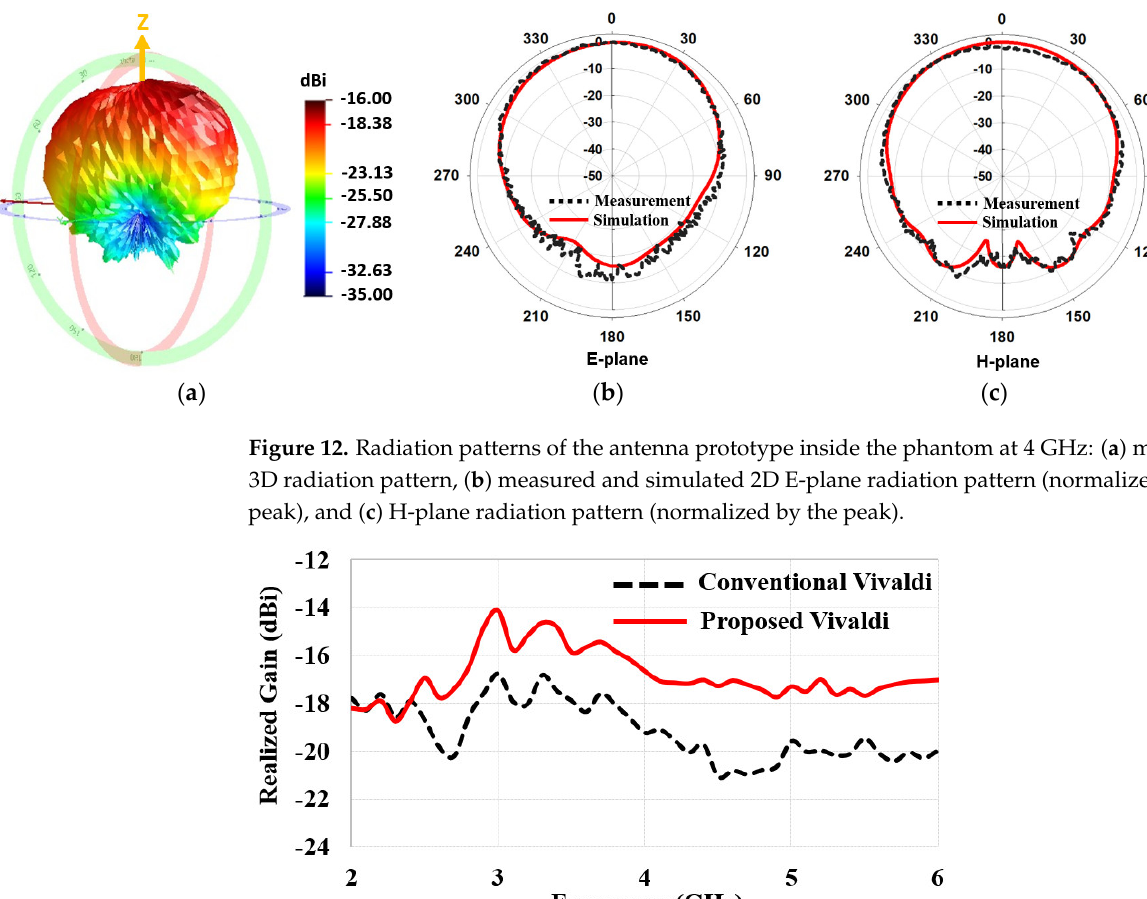
Figure 13. A comparison of measured realized gain of the conventional and proposed Vivaldi antennas. Table 3. Comparison of brain-implanted antennas.